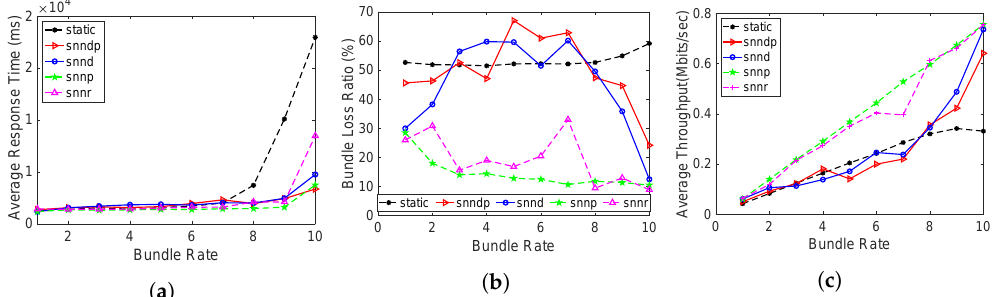
Figure 17. Routing performance: Scenario 9. ( a ) Average response time; ( b ) Packet loss ratio (%); ( c ) Throughput.